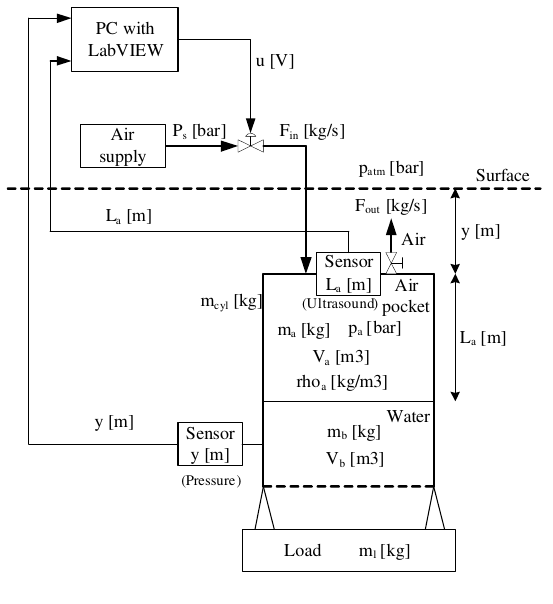
Figure 1: The lifting body with load.